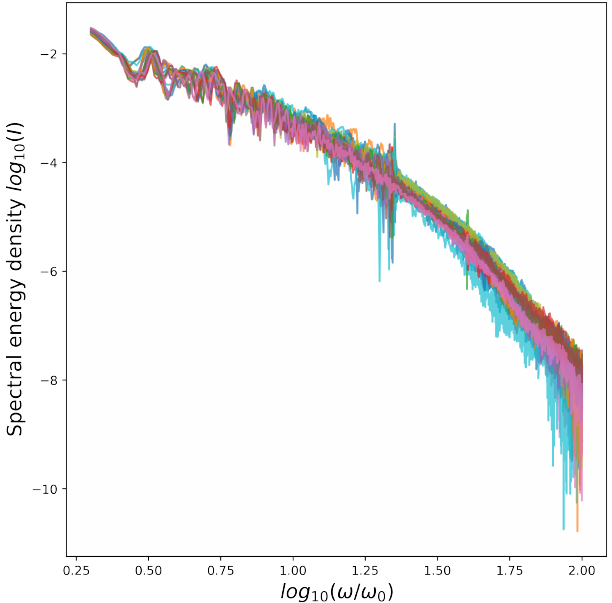
Figure 3. Neighboring spectra for spectrum with the parameters Φ CEP = 102, θ = 0.25, L p = 0.33. I is the spectral energy density given in a.u.